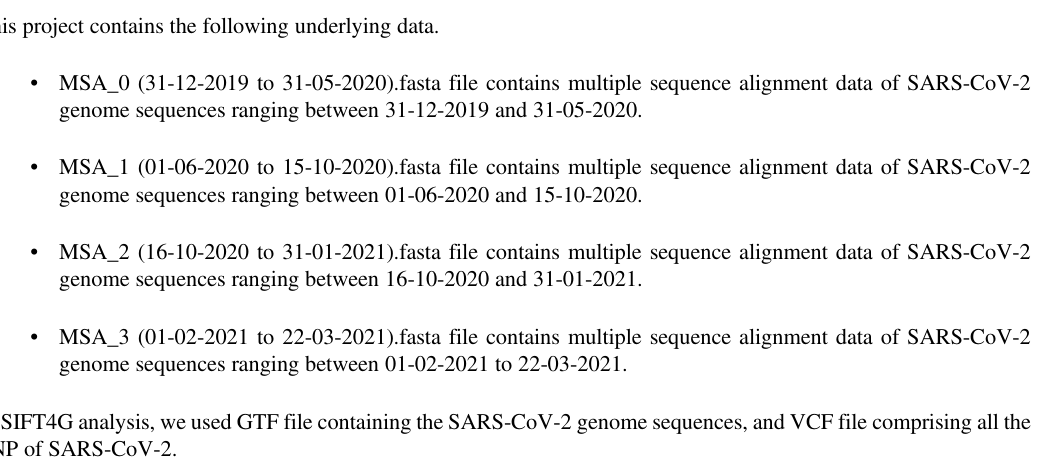
Figshare: MSA (SARS-CoV-2). https://doi.org/10.6084/m9.figshare.16681900.v4 42